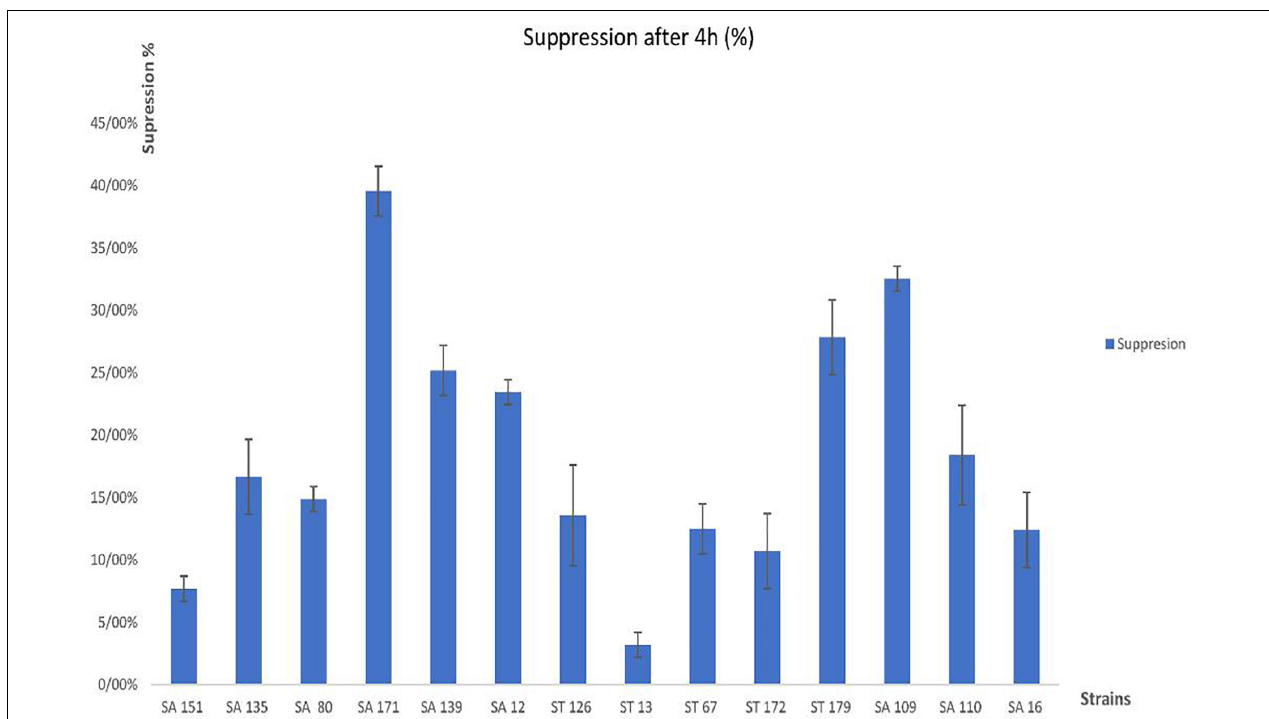
FIGURE 1 | Percentage growth inhibition (suppression) of the 14 selected isolates by bile salts. TABLE 3 | Antimicrobial activities against ten pathogens. Strains S. aureus